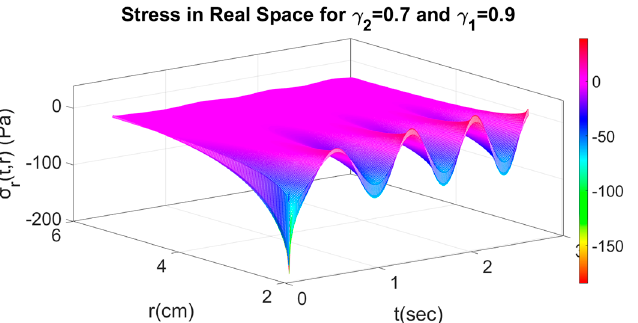
Figure 16. Distribution of the radial stress σ r ( t , r ) in the initial space with space (porosity) fractional order γ 1 = 0.9 and time fractional order γ 2 = 0.7.